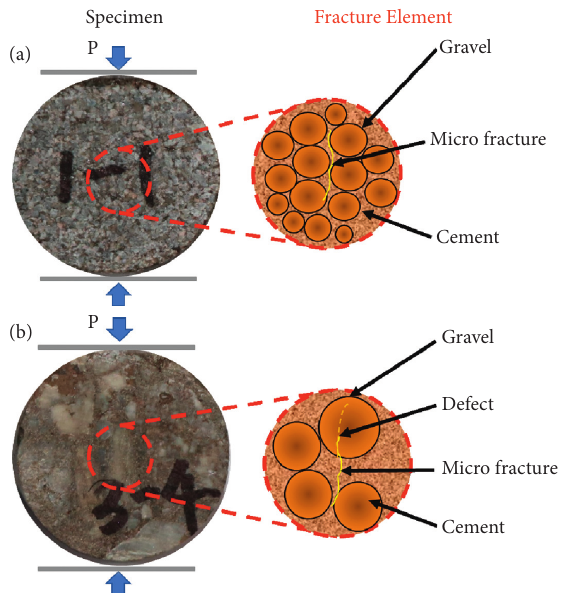
Figure 4: Fracture element of the conglomerate specimen: (a) fine- grained; (b) medium-grained.